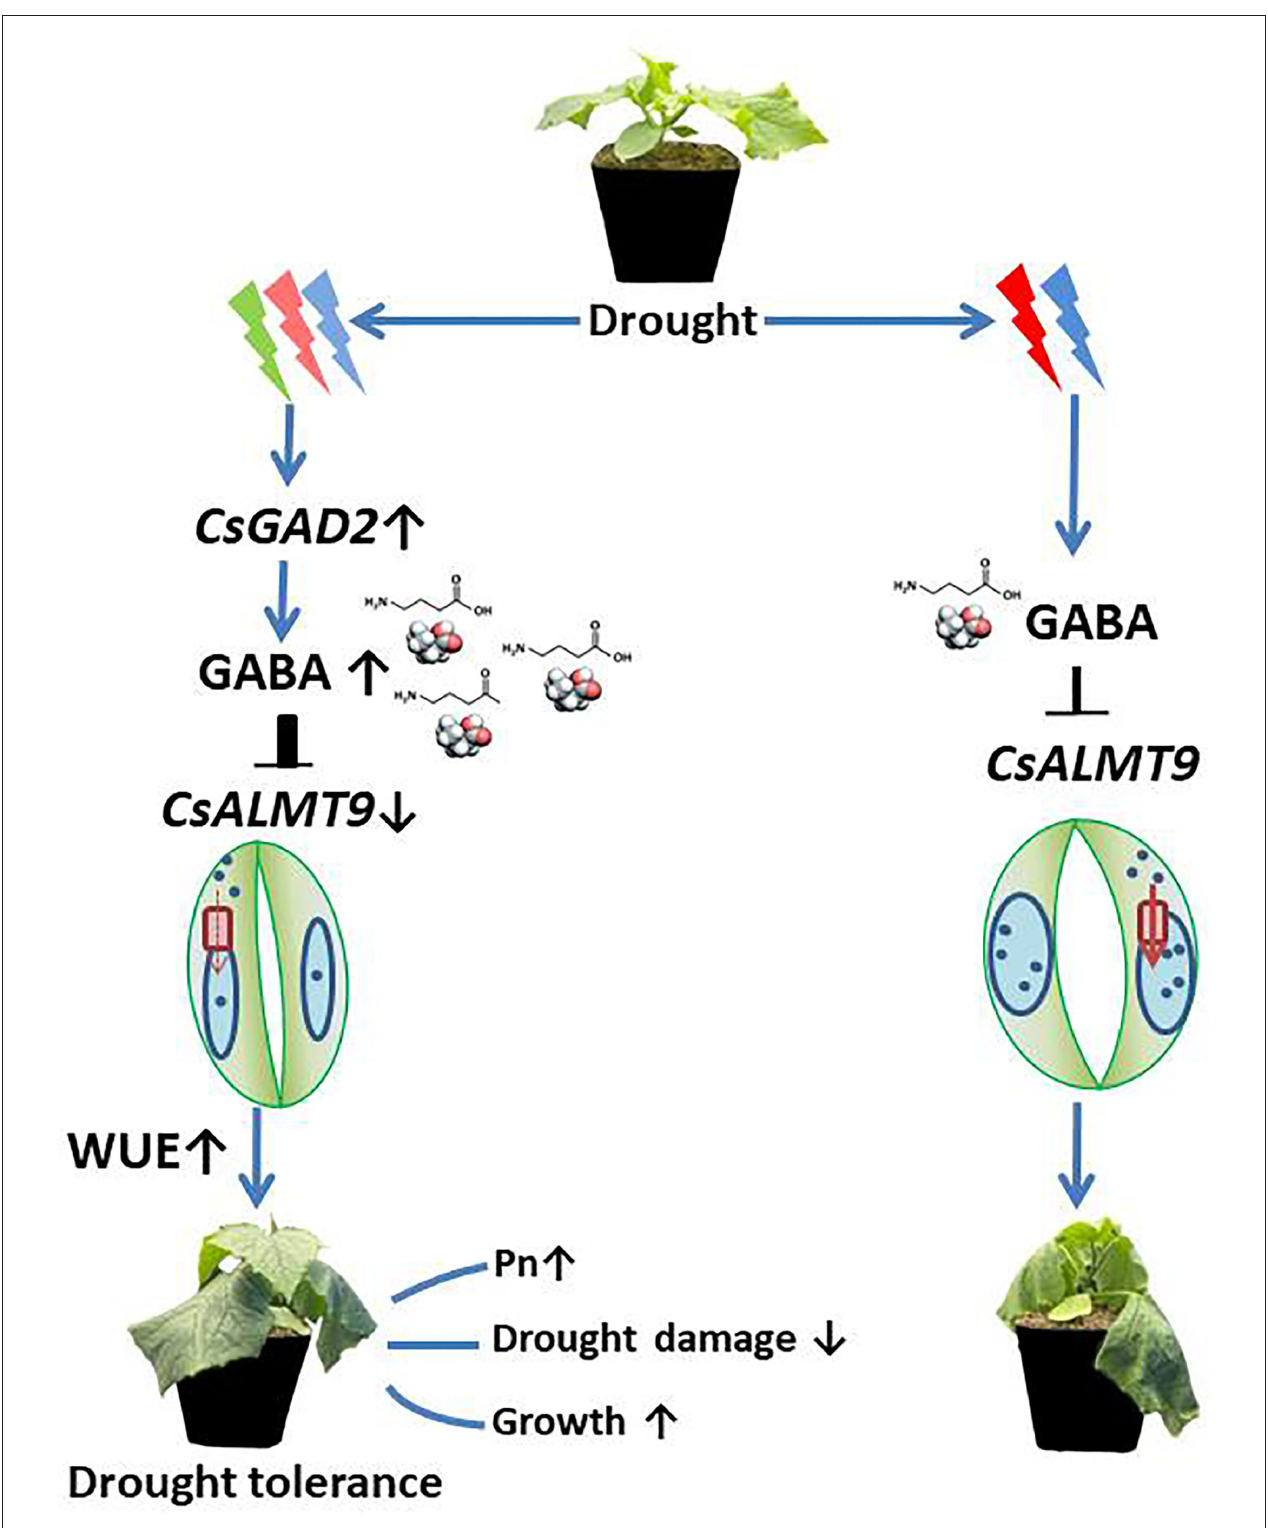
FIGURE 10 | Proposed model of the regulation pathway of green light on plant drought resistance. Green light stimulates the up-regulation of CsGAD2 , thus promoting the synthesis of GABA, and regulates stomatal opening and water use efficiency drought resistance through negative regulation of the expression level of CsALMT9 . Since green light replaces part of red and blue light, compared with red and blue light, green light upregulated the expression of CsGAD2 gene under